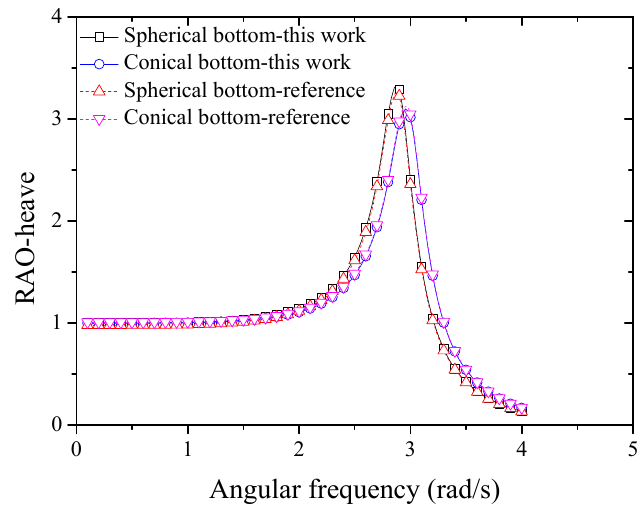
Figure 6. Comparison between simulated RAO-heave with the results of Liu [40] for di ff erent float Figure 6. C omparison between simulated RAO-heave with the results of Liu [40] for different float bottom bottom shapes.